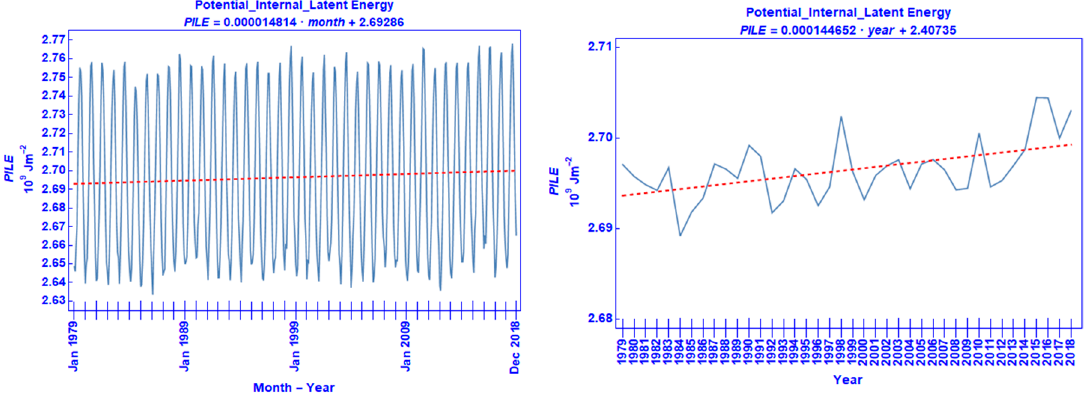
Figure 11. The same as Figure 2, but for PILE .